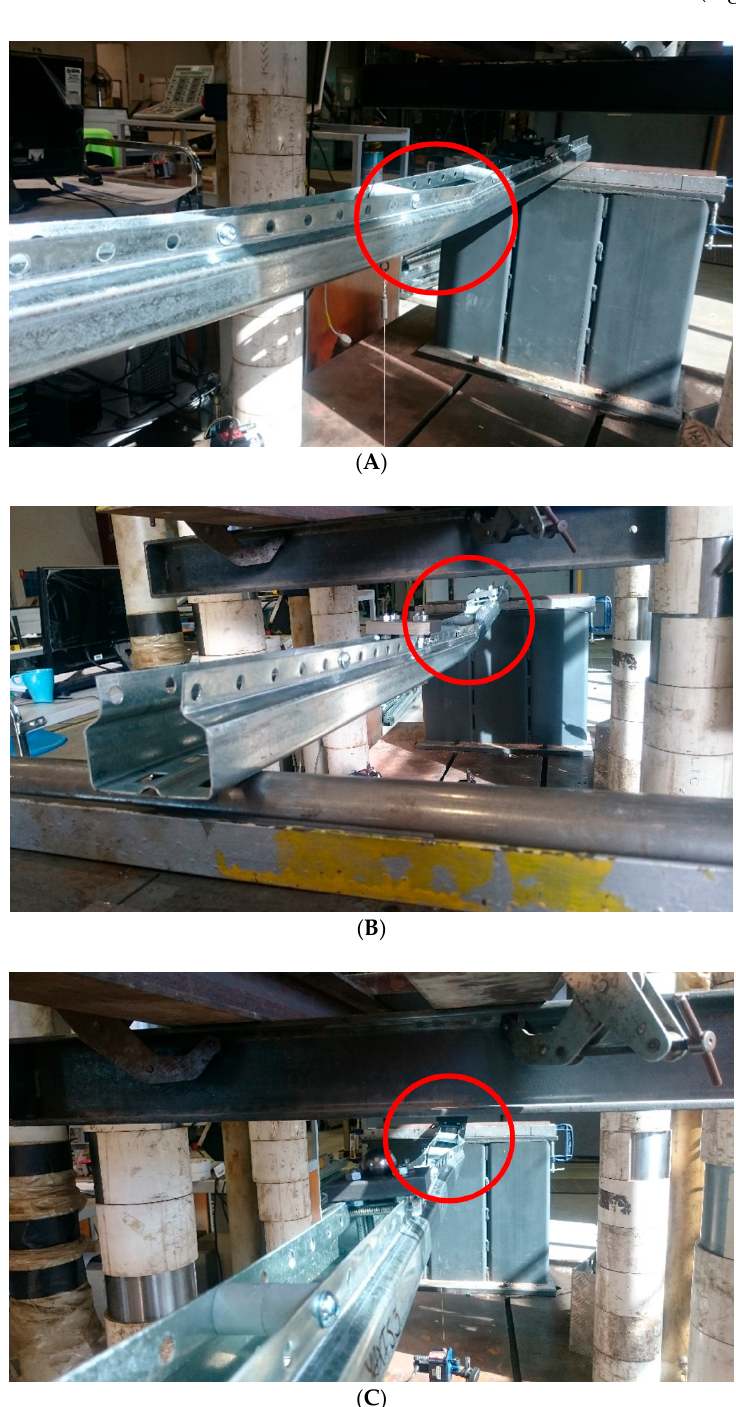
Figure 19. The observed failure mode for reinforced specimens with 300 mm reinforcing pitch during the minor axis test: ( A ) 300RMIM-test1; ( B ) 300RMIM-test2; ( C ) 300RMIM-test3.